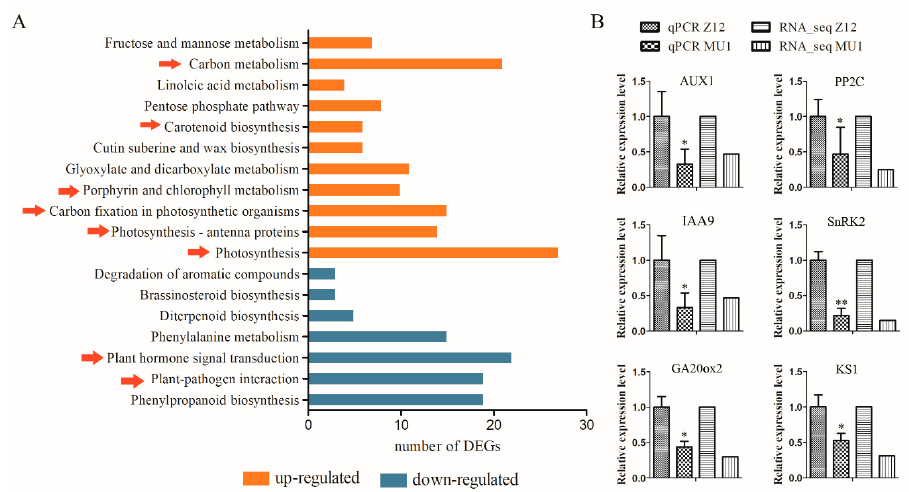
Figure 7. Kyoto Encyclopedia of Genes and Genomes (KEGG) pathway analysis and qPCR of genes differentially expressed in MU1 compared with Z12. ( A ) KEGG enrichment analysis. The Y-axis represents various pathways. The X-axis represents the numbers of DEGs. Up-regulated pathways are indicated in orange, and down-regulated pathways are indicated in blue ( p < 0.05). ( B ) Expression analysis of DEGs involved in the plant hormone signal pathway. The relative expression level of some DEGs were determined, such as auxin transporter-like protein 1 (AUX1, Os09g0490200), IAA9 (Os02g0805100), protein phosphatase 2C (PP2C, Os09g0325700), SNF1-related kinase2 (SnRK2, Os03g0610900), Gibberellin20 oxidase 2 (GA20ox2, Os01g0883800), and GA biosynthesis gene KS1